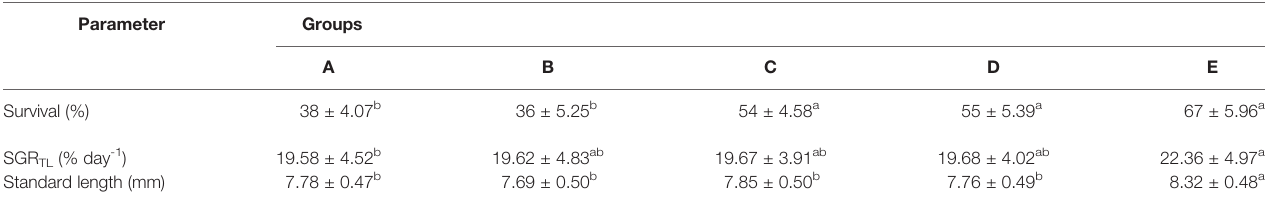
TABLE 1 | Survival, SGR and standard length of S. lucioperca larvae at 17 (n= 60) days post hatch (DPH).